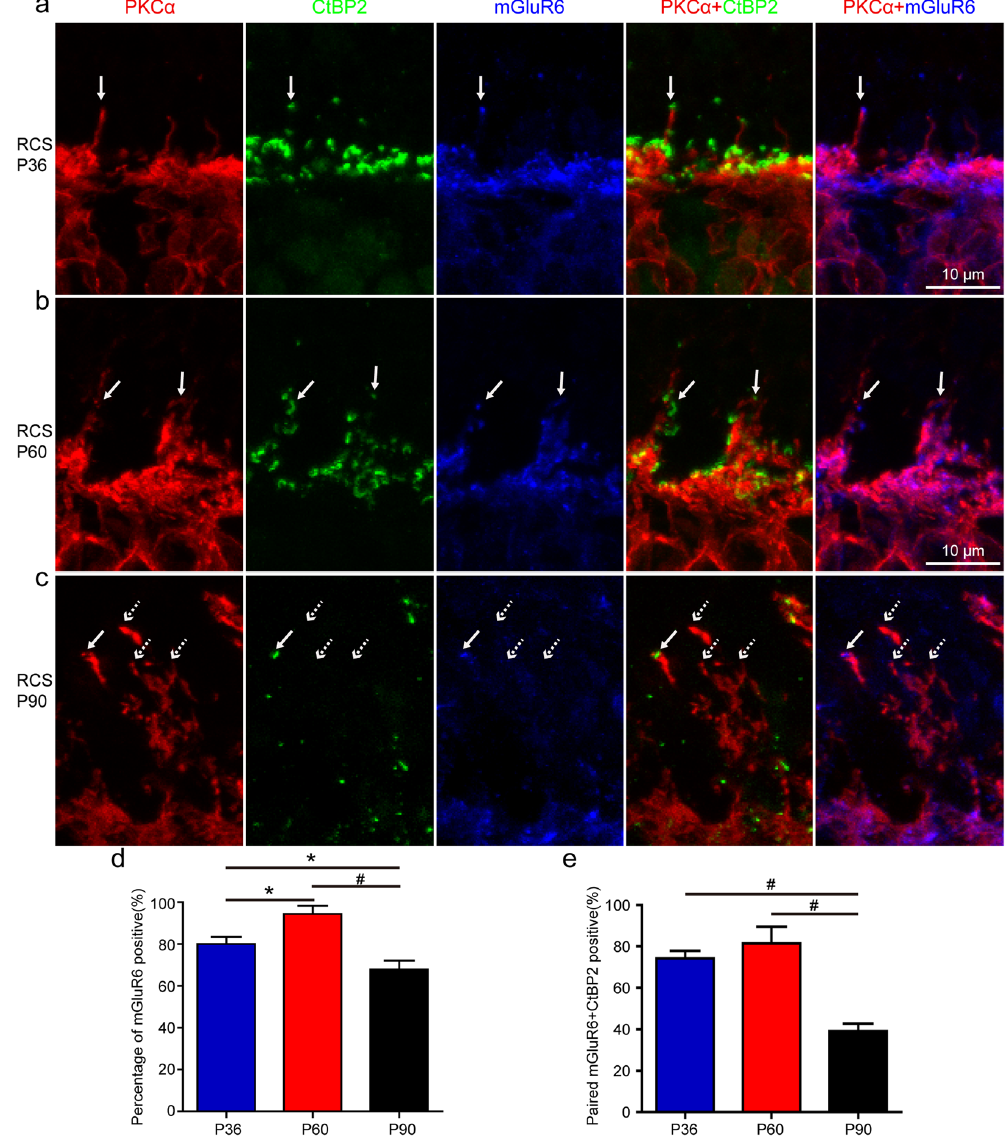
Figure 2. RBC ectopic dendrites in RCS rats formed synapses with the remaining photoreceptors. Immunostaining for PKC α , CtBP2 and mGluR6 in the retinae of ( a ) P36, ( b ) P60 and ( c ) P90 RCS rats. Solid arrows indicate tips of ectopic dendrites that were mGluR6 positive and paired with CtBP2 puncta. Dotted arrows indicate tips of ectopic dendrites that were mGluR6 negative or did not pair with the CtBP2 puncta. ( d ) Proportion of mGluR6-positive RBC ectopic dendrites in RCS rats at P36, P60 and P90, per field view (213 µ m × 213 µ m) (n = 5) ( e ) Proportion of mGluR6-positive RBC ectopic dendrites paired with CtBP2 in RCS rats per field view (n = 5). Bars show means; error-bars, SEM; * p < 0.05; # p <